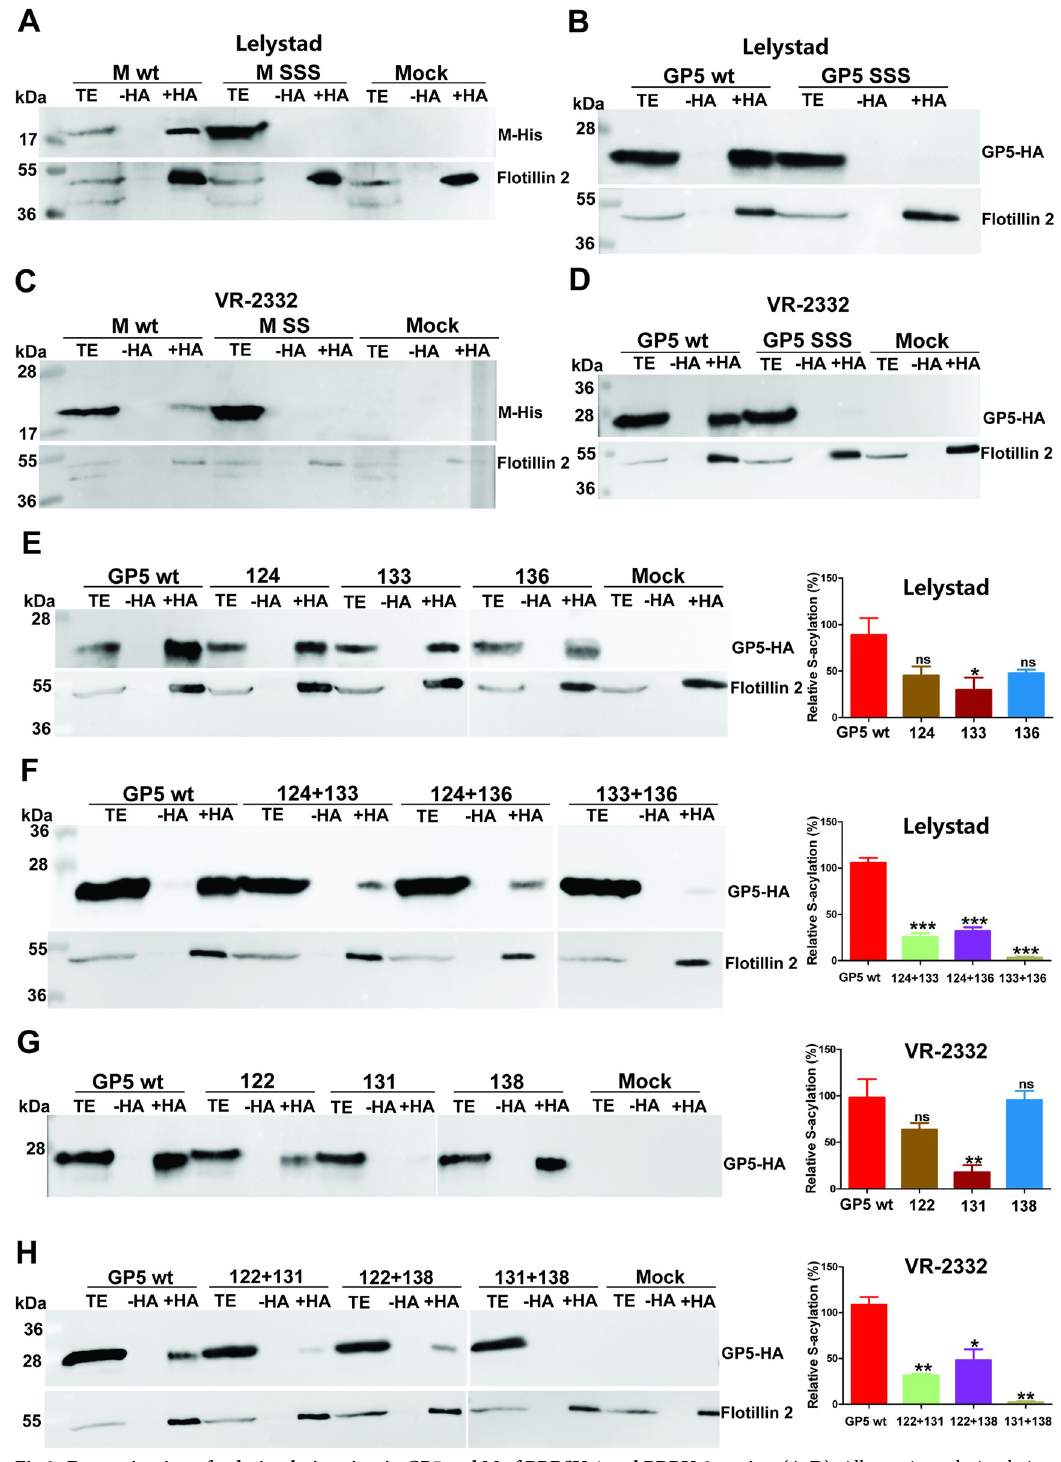
Fig 3. Determination of palmitoylation sites in GP5 and M of PRRSV-1 and PRRV-2 strains. (A-D): All putative palmitoylation sites in M (A+C) and GP5 (B+D) of PRRSV-1 prototype strain Lelystad (A+B) and PRRSV-2 prototype strain VR-2332 (C+D) were exchanged to serine. Plasmids with the indicated mutations were transfected into 293T cells and palmitoylation was determined with Acyl-Rac. Anti-His antibodies were used to detect M-His and anti-HA antibodies to detect GP5-HA. Staining of the same membrane with antibodies against the cellular palmitoylated protein Flotillin 2 served as a control for sample processing. (E-H):